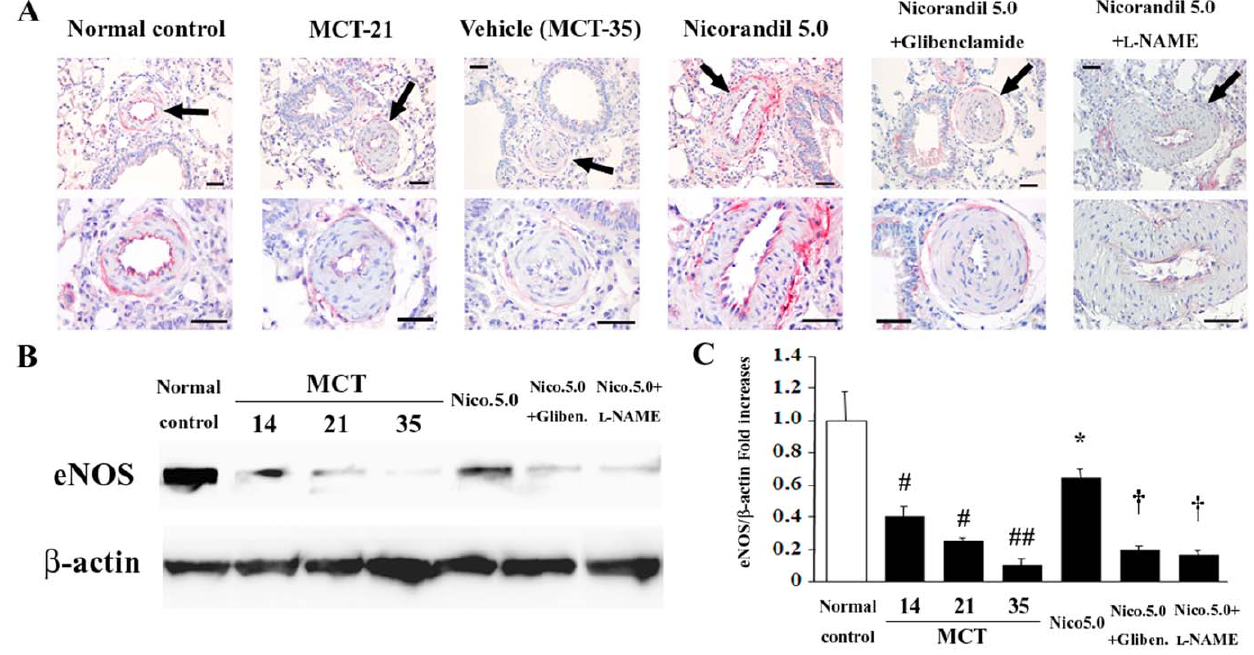
Figure 6. Nicorandil restores eNOS expression in the pulmonary vascular endothelium in established PAH. ( A ) Immunohistochemical staining for eNOS in lung sections in the reversal protocol. Arrows indicate the PAs. Scale bar, 50 m m. ( B ) Detection of eNOS expression in lungs by western blotting in this protocol. MCT downregulated eNOS expression in a time-dependent manner, whereas late treatment with nicorandil resulted in partial restoration of eNOS expression. ( C ) Bands in panel (B) were quantified, and eNOS expression data were expressed as fold increases normalized to b -actin expression. # P , 0.01 vs. normal control; ## P , 0.01 vs. normal control and P , 0.05 vs. MCT-14; * P , 0.01 vs. MCT-35; { P , 0.01 vs. nicorandil (5.0 mg ? kg 2 1 ? day 2 1 ).